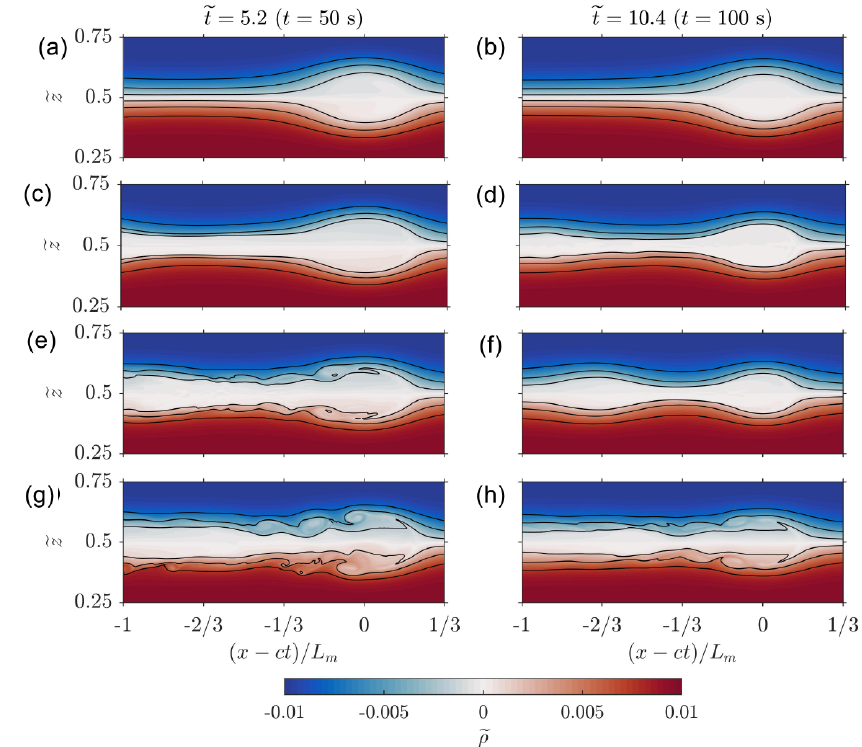
Figure 9. Density anomaly, e ρ , at e y = 0 for f/f 0 = (a, b) 0, (c, d) 1 / 4, (e, f) 1 / 2, and (g, h) 1. Black contours are equispaced isopycnals between ρ(z 0 − h) and ρ(z 0 + h) . All cases have Sc = 10.